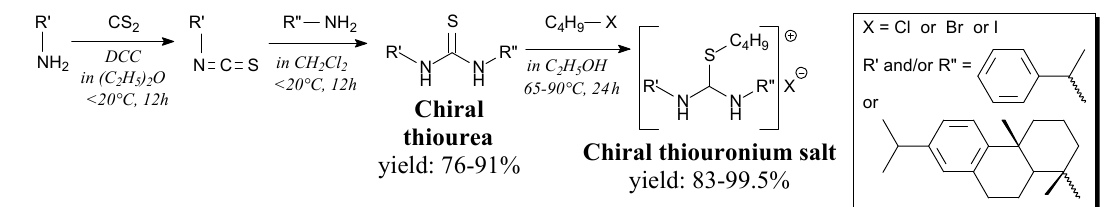
Scheme 50. Synthesis of chiral thioureas and their thiouronium salts.